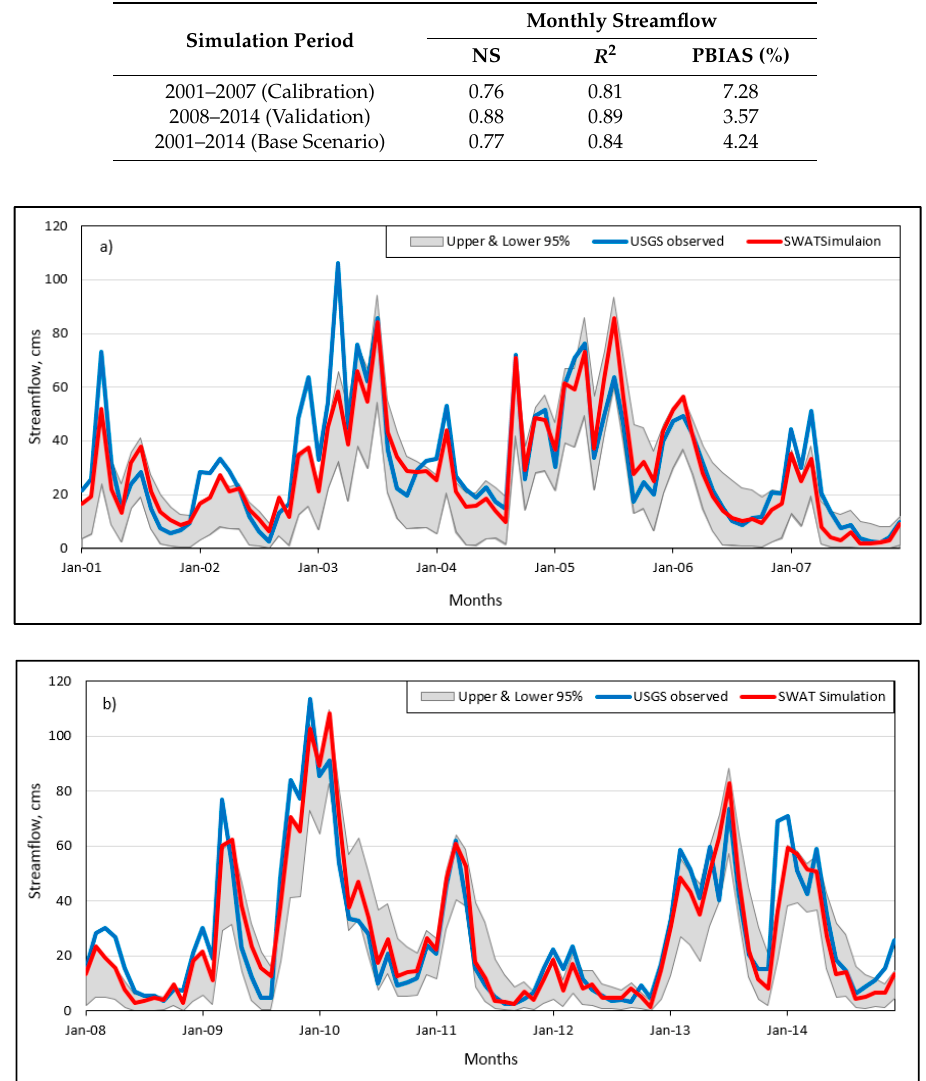
Figure 8. Trajectories of the observed USGS average monthly streamflow, SWAT best simulated average monthly streamflow, and upper and lower 95% prediction uncertainty band for ( a ) calibration period (January 2001 to December 2007) and ( b ) validation period (January 2008 to December 2014).